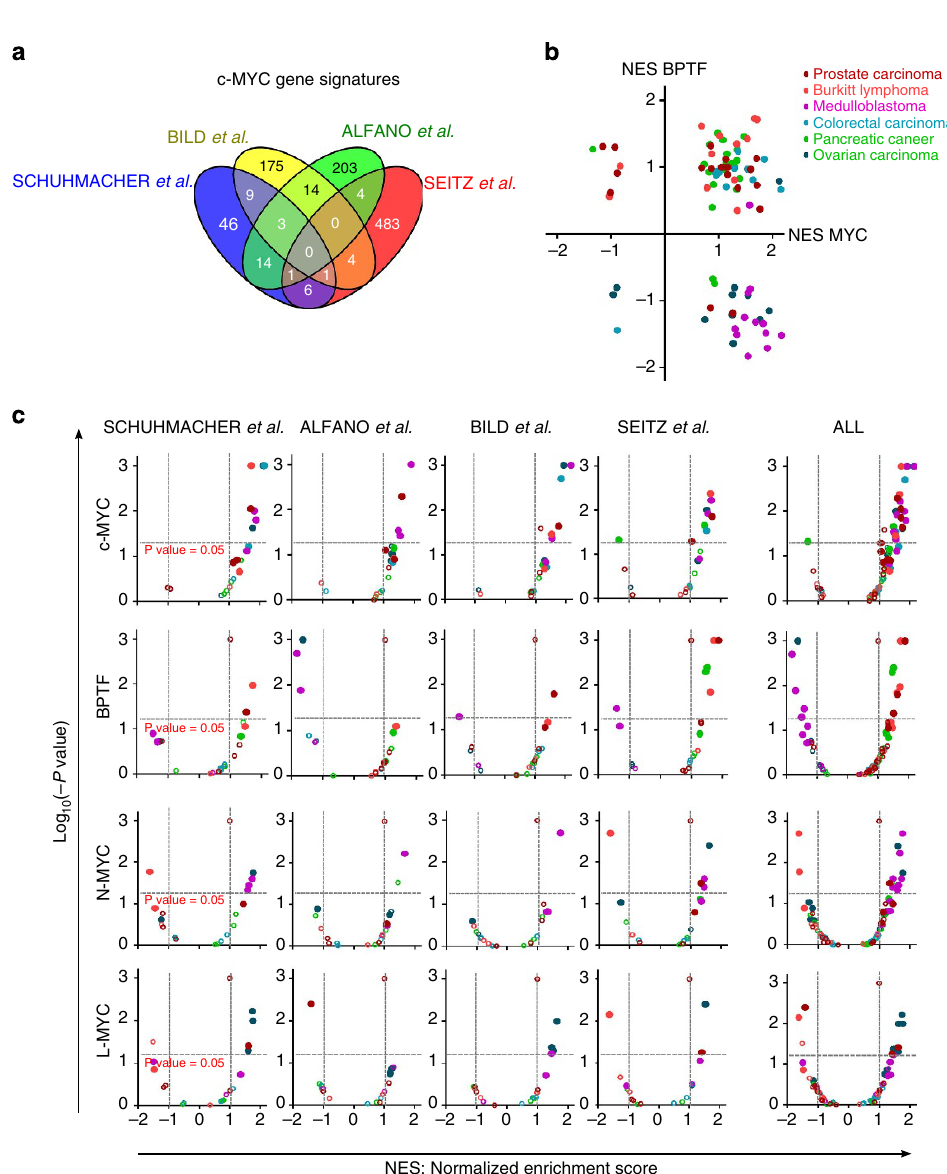
Figure 5 | BPTF expression correlates with c-MYC signatures in human tumours. ( a ) Venn diagram showing the overlap of the c-MYC signatures used in the following analyses. ( b ) Dot plot of normalized enrichment scores (NES) of the four c-MYC signatures based on GSEA. NES values were calculated for each data set previously ranked-ordered by either BPTF or c-MYC levels. ( c ) Volcano plots of NES and enrichment P values of c-MYC signatures based on GSEA. NES values were calculated for each data set previously ranked-ordered by BPTF, c-MYC, N-MYC or L-MYC mRNA levels. Filled circles represent gene sets with a false discovery rate o